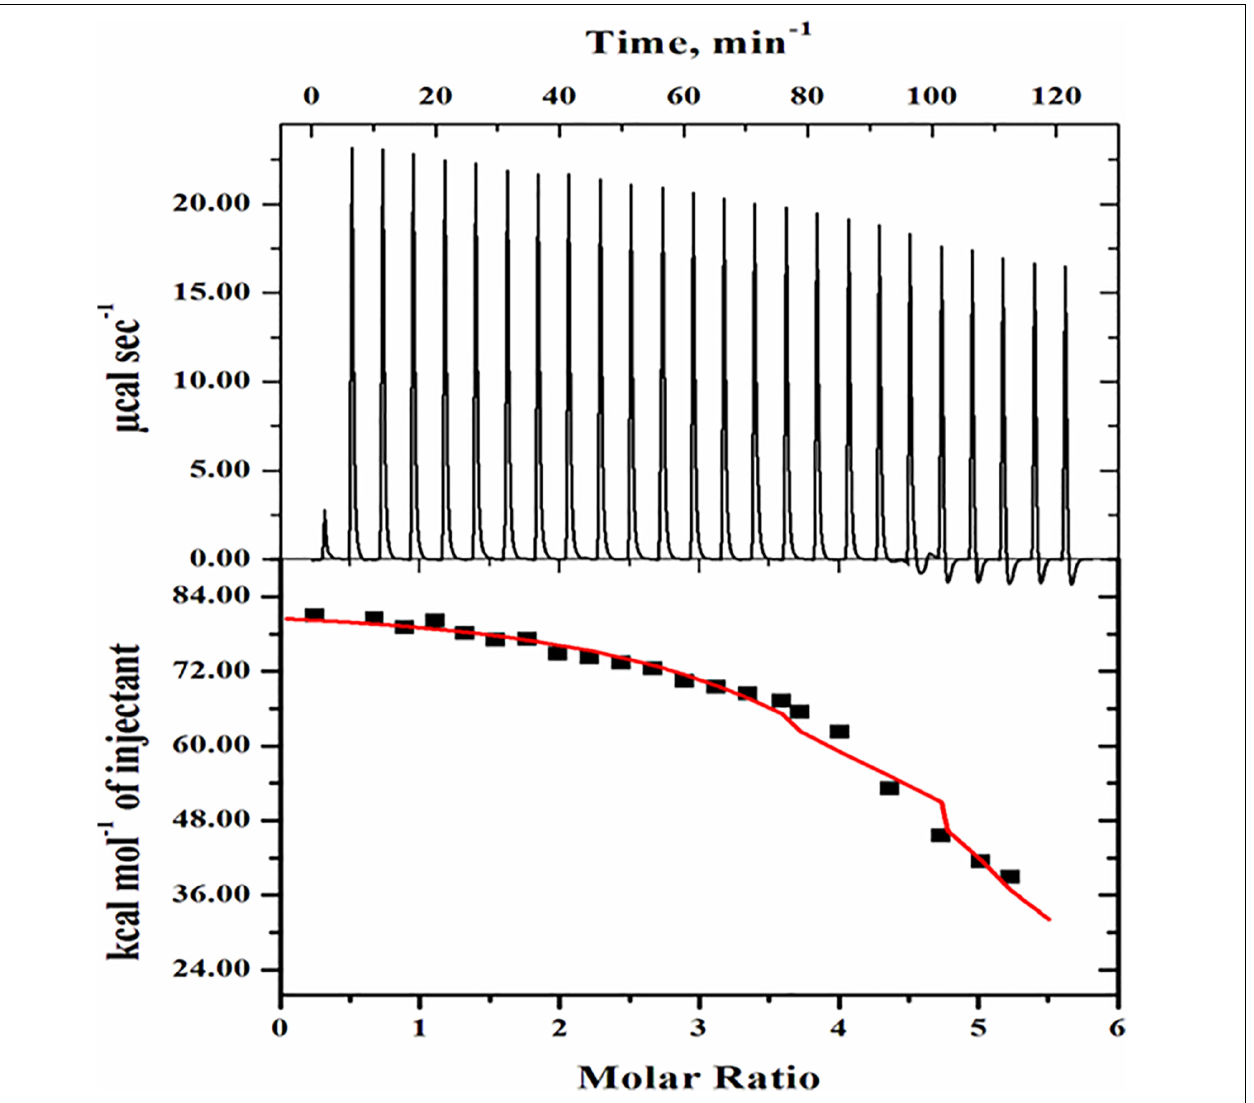
FIGURE 8 | Isothermal calorimetric titration of BSA in presence of monosodium glutamate. The top side panel shows the raw data in the power versus time (heat per unit of time released after each injection of the ligand into the protein). The bottom side panel shows the raw data in the power standardization to the amount of injections (kcal mol − 1 ) versus its molar ratios with the addition of consecutive injections of monosodium glutamate into the cell reaction containing BSA protein solution. TABLE 1 | Binding parameters of BSA with monosodium glutamate evaluated from ITC measurements at pH 7.0 and 25 ◦ C. Thermodynamic parameters